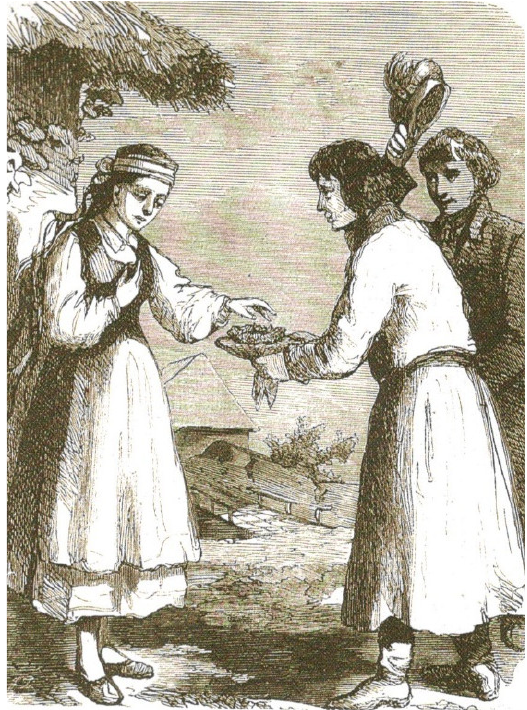
Figure 10. Mother gives of the wedding crown [13].